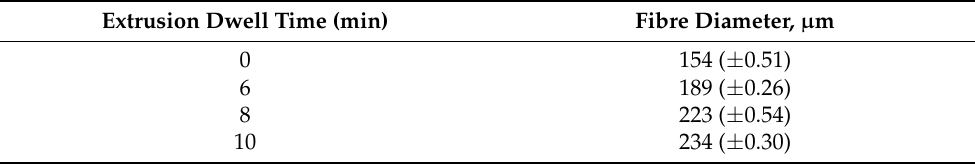
Table 2. Fibre diameter for LLDPE/MP as a function of extrusion dwell